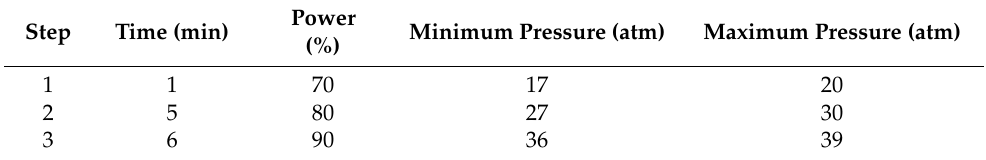
Table 2. Stages and conditions of mineralization.